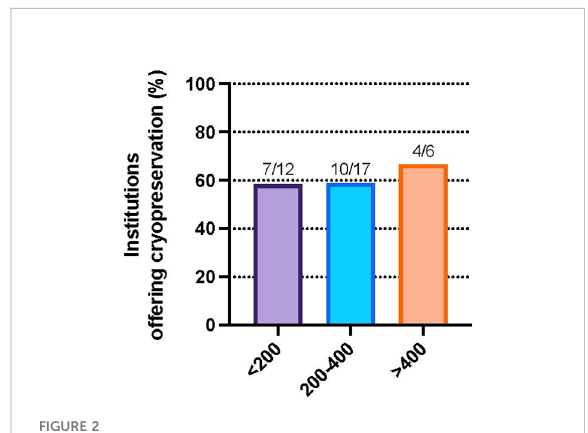
FIGURE 2 Percent of institutions that participated in the survey and offer gonadal cryopreservation for DSD patients by facility beds, <200 beds (58.3%), 200-400 beds (58.8%), and >400 beds (66.7%),